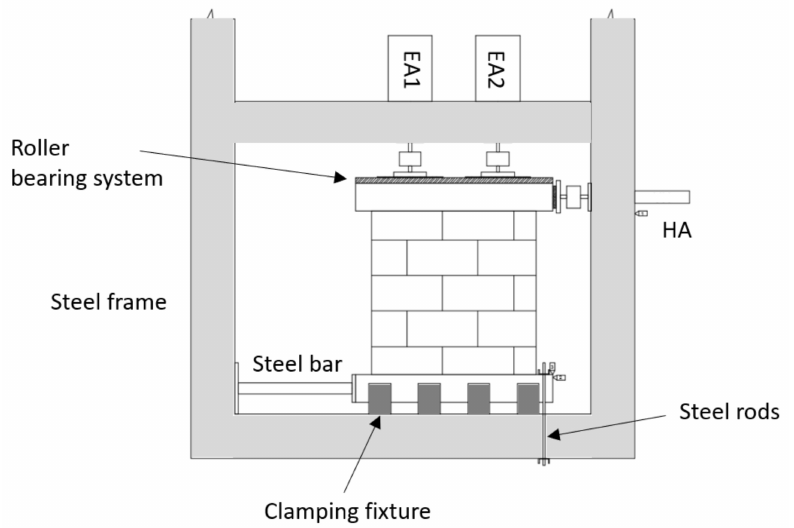
Figure 2. Experimental setup of a URM